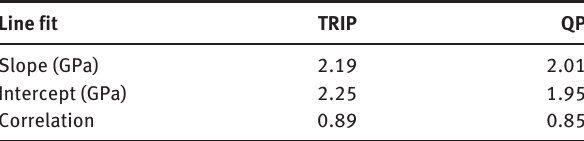
Table 1 Statistics of best line fit for Figure 2B data.